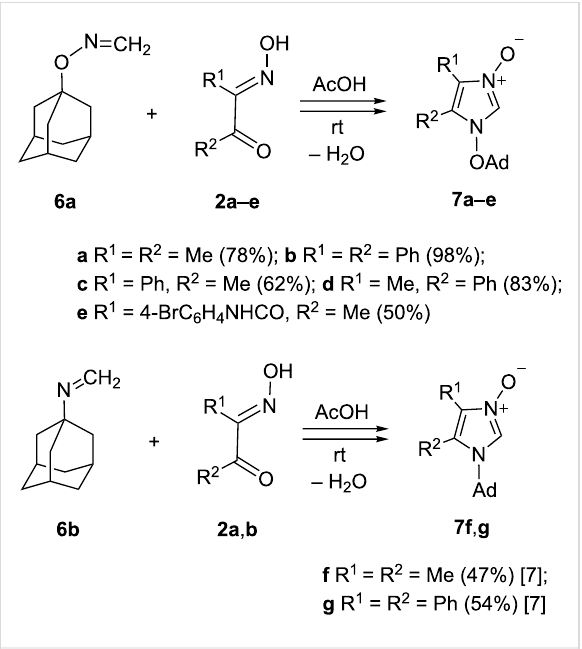
N -oxides 7f and 7g , bearing the adamantan-1-yl moiety at- tached to N(1), were also obtained in high yields starting with (adamantyl)formaldimine ( 6b , Scheme 3). In this case, crude products were isolated as hydrochlorides not by treatment with hydrochloric acid but with gaseous hydrogen chloride (proce- dure B). Both compounds obtained by this method were fully characterized and described in an earlier publication